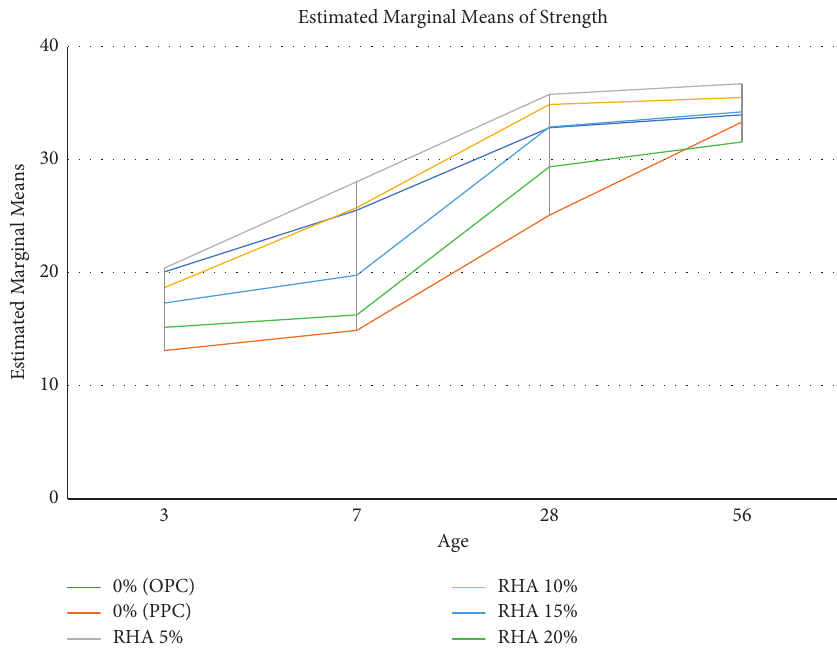
Figure 8: Profile plots for different RHA replacement levels. Table 6: Statistical analysis results of the main effects and interaction effect [52].